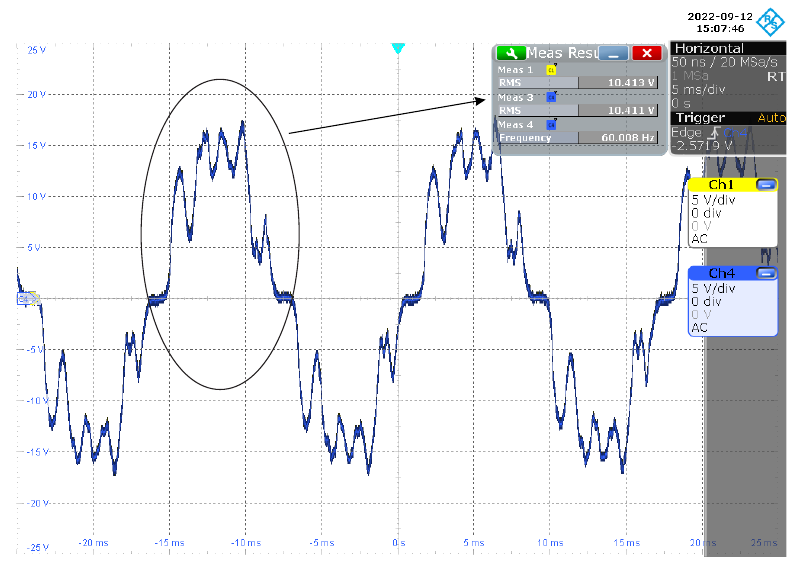
Figure 12. The waveform of the voltage signal at the output of the NB–PLC notch coupling circuit.